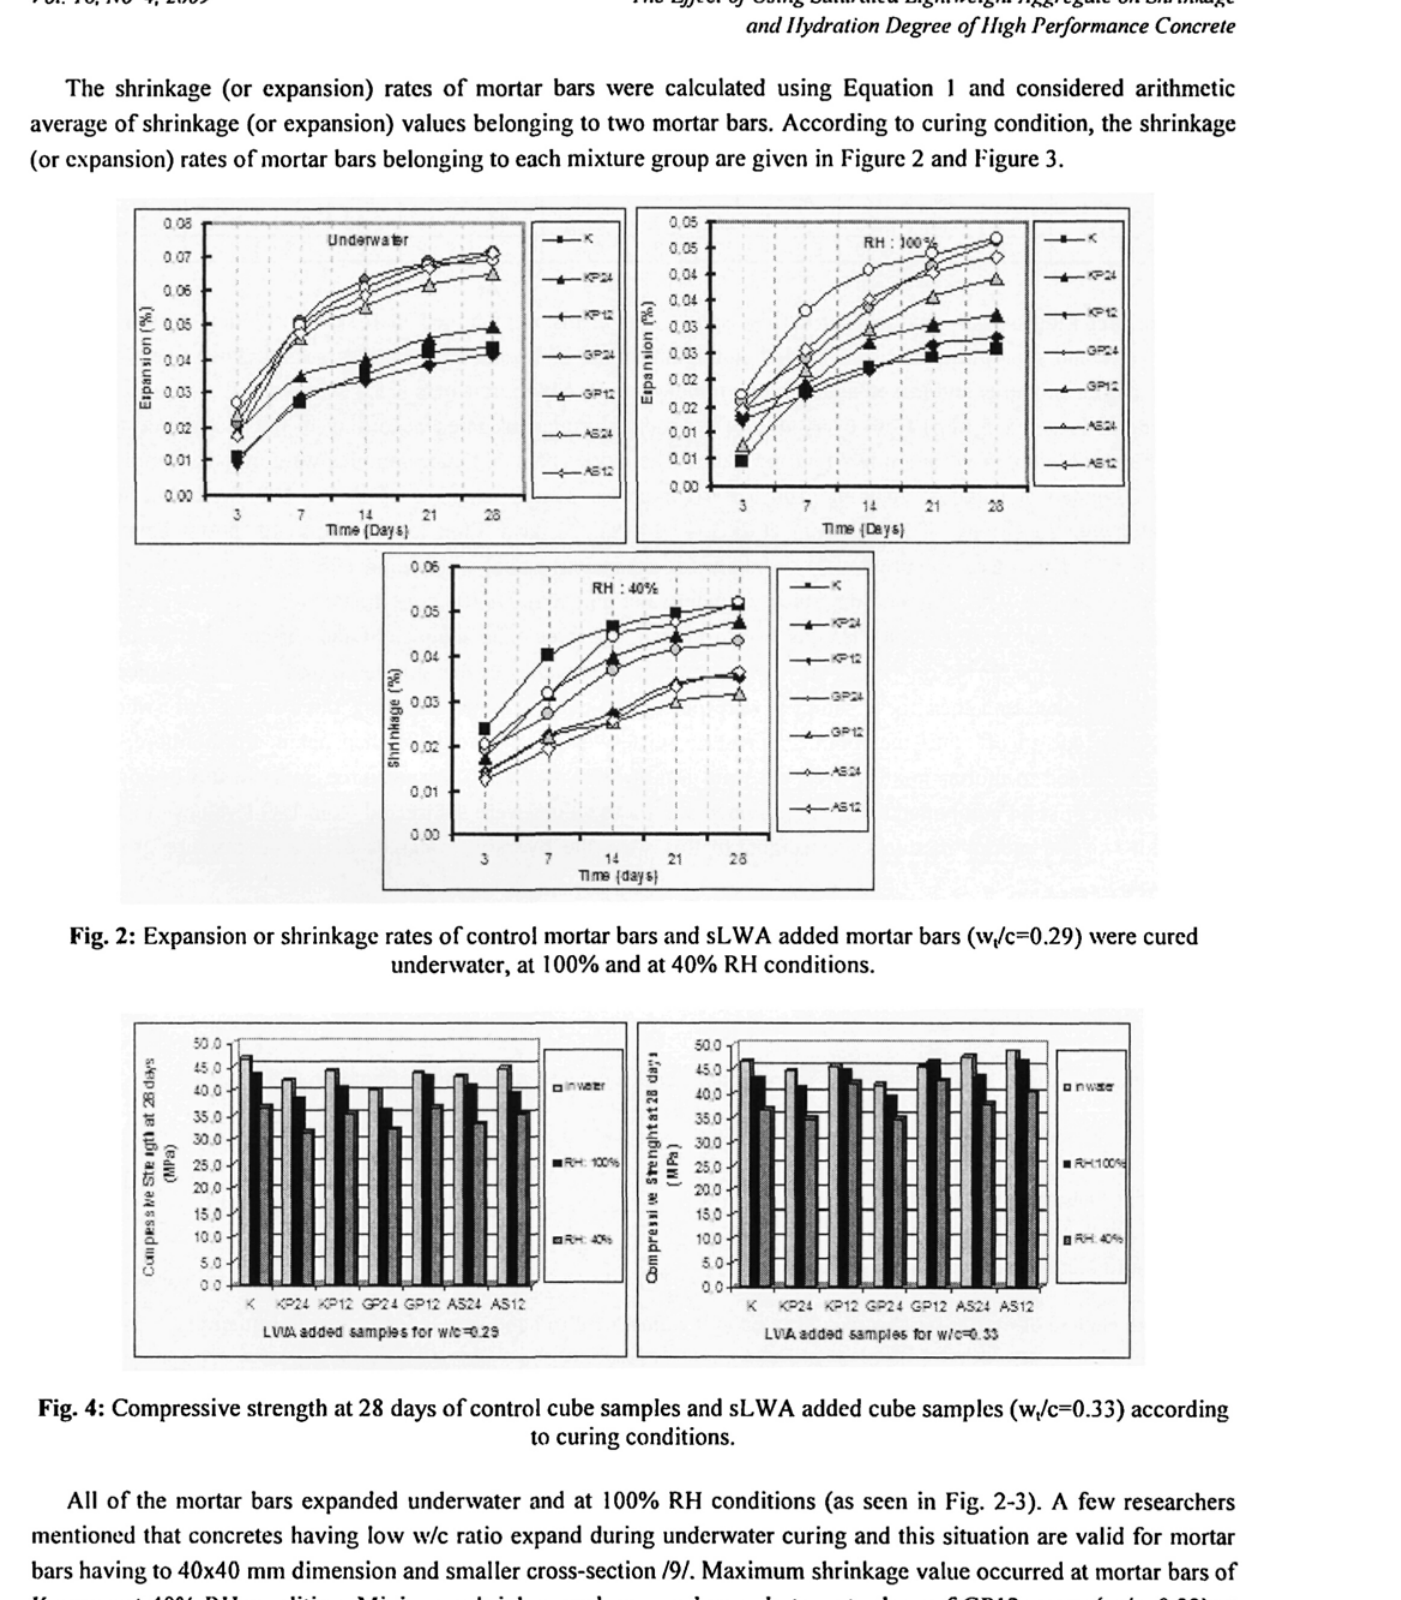
Fig. 2: Expansion or shrinkage rates of control mortar bars and sLWA added mortar bars (w,/c=0.29) were cured underwater, at 100% and at 40% RH conditions.